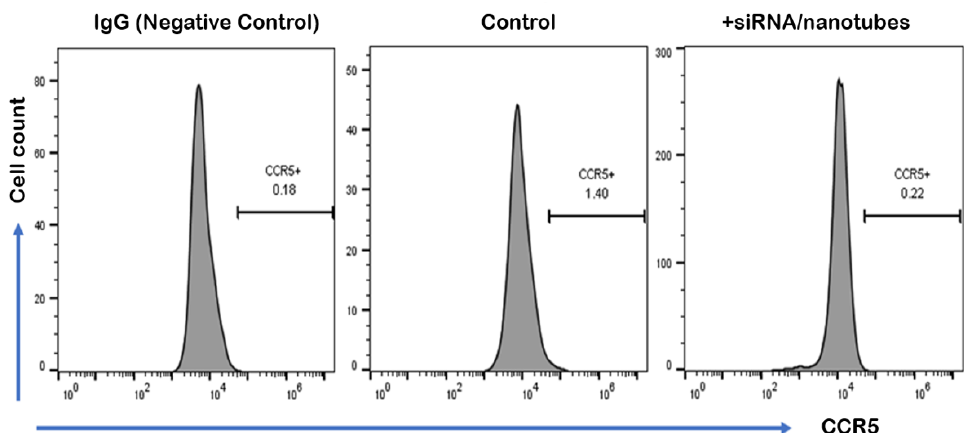
Figure 7. Downregulation of CCR5 in HepG2 cells by siRNA/nanotubes complex. CCR5 expression was detected by flow cytometry after nanotubes-delivered siRNA-mediated knockdown for 48 h. IgG staining was used for isotype control ( left ). Control indicated natural expression of CCR5 in HepG2 cells without any treatment ( middle ) compared to CCR5-targeting siRNA/nanotubes treatment ( right ).